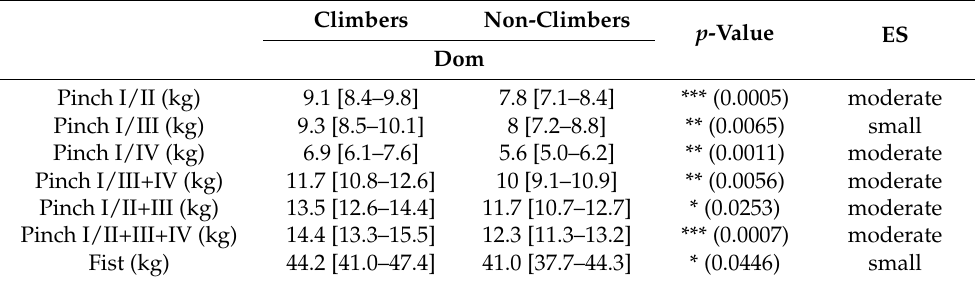
Table 2. Analysis of different pinches with regards to grip strength between climbers and non- climbers measured in the dominant (Dom) and non-dominant (Non-dom) hand. Differences of each pinch between climbers and non-climbers are depicted (unpaired t-test), and effect size (ES) is